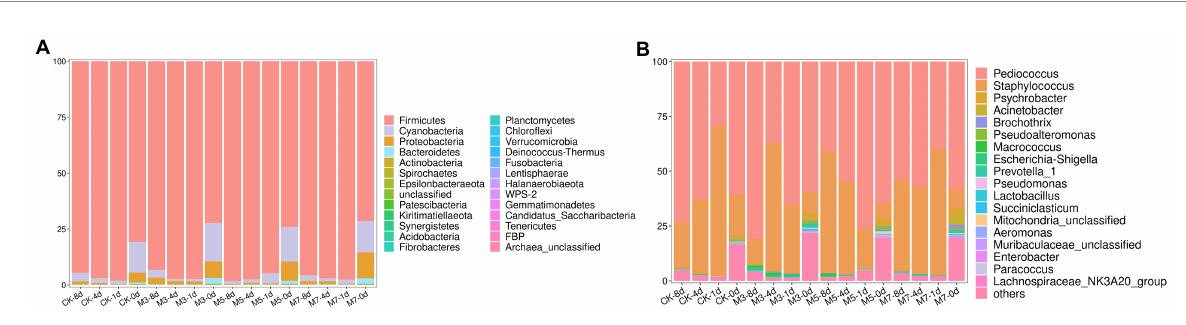
FIGURE 1 Relative abundance of bacteria community proportions based on 16S rDNA sequencing at phylum (A) and genus (B)